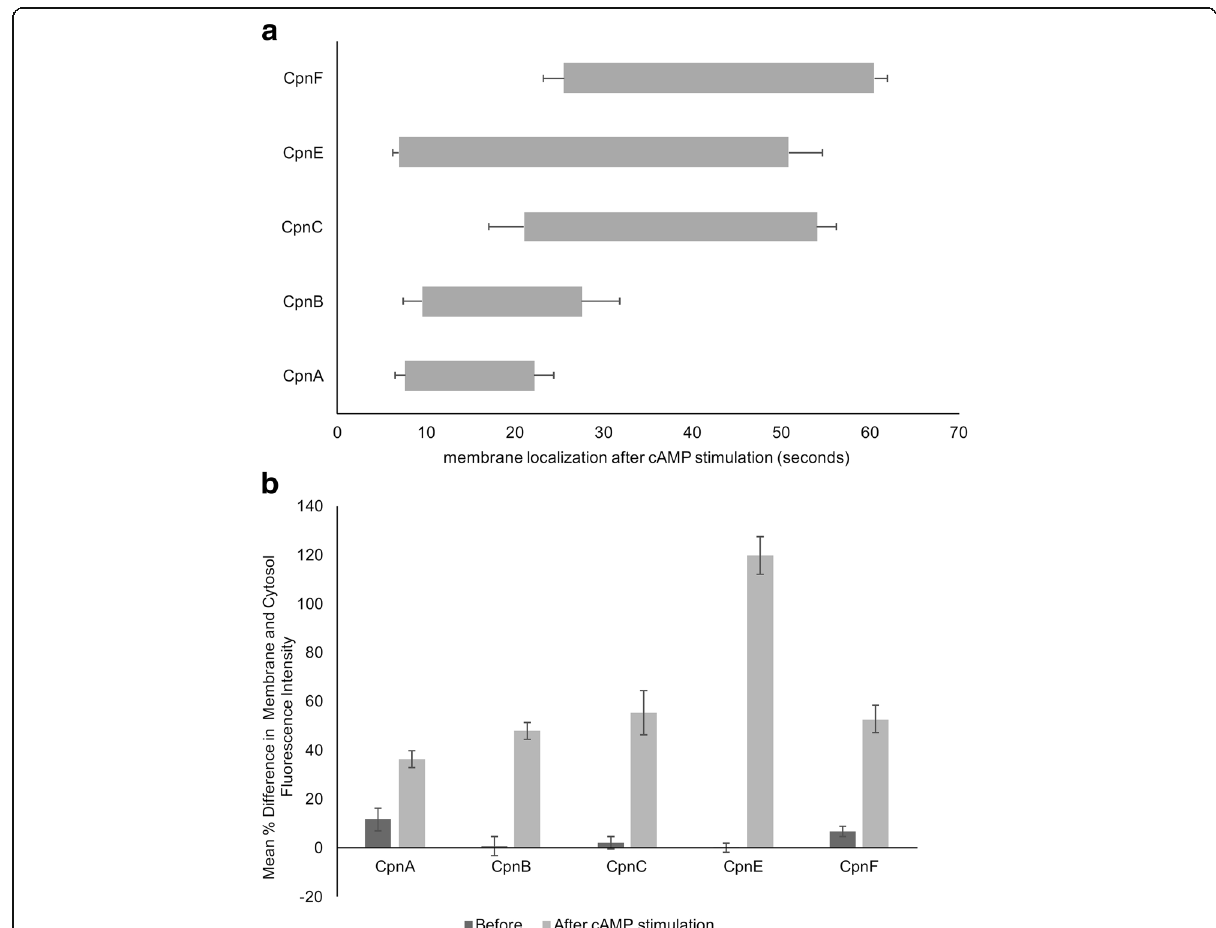
Fig. 4 Copines translocate to the plasma membrane with various on and off times and magnitudes after cAMP stimulation. a Time-lapse images of individual cells were obtained as described in Fig. 3 and were analyzed by determining the time at which the GFP-tagged copine was first observed to be enriched on the plasma membrane and the time at which the GFP-tagged copine was no longer enriched on the plasma membrane. Times for at least six and up to 21 cells for each copine regardless of the location of the GFP were averaged. Error bars = standard error. b Time-lapse images of individual cells were analyzed for mean fluorescence intensity in the cytosol and on the plasma membrane. The percent difference between the mean fluorescence intensity on the plasma membrane and the cytosol was calculated using images taken before cAMP stimulation and images in which the most membrane localization was observed after cAMP stimulation. The percent differences were averaged for six cells for each copine. Error bars=standard